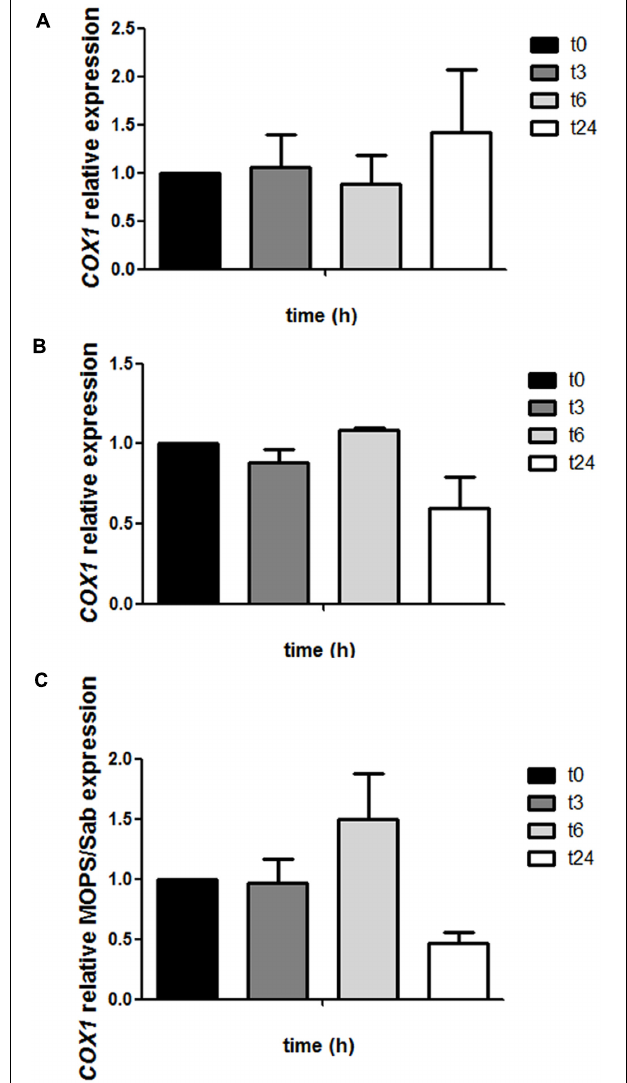
FIGURE 5 | Analysis of COX1 expression during capsule induction. Cells from H99 strain were grown in Sabouraud and capsule inducing medium at 37 ◦ C and RNA was isolated from samples were collected at different times (0, 3, 6, and 24 h). cDNAs were obtained and relative expression of the COX1 gene was measured by real-time PCR as described in Section “Materials and Methods.” COX1 gene expression at different time points in Sabouraud medium (A) and capsule inducing medium (B) . Then, a relative fold change comparing at each time point the difference between the capsule inducing medium and Sabouraud was plotted in (C) . This experiment was performed in